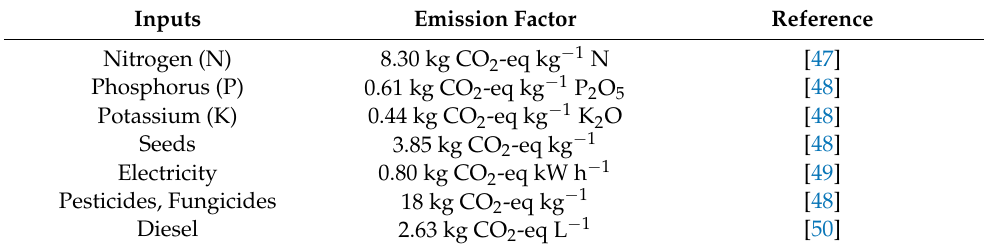
Table 2. Emission coefficient for each input used in the present